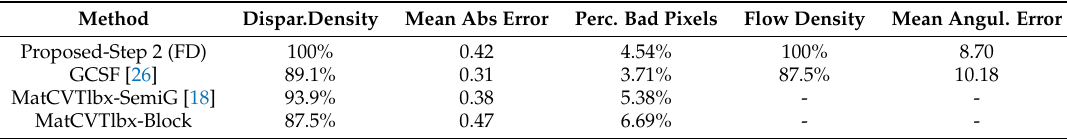
Table 3. Comparative results for the “Rotating Lenna plane”